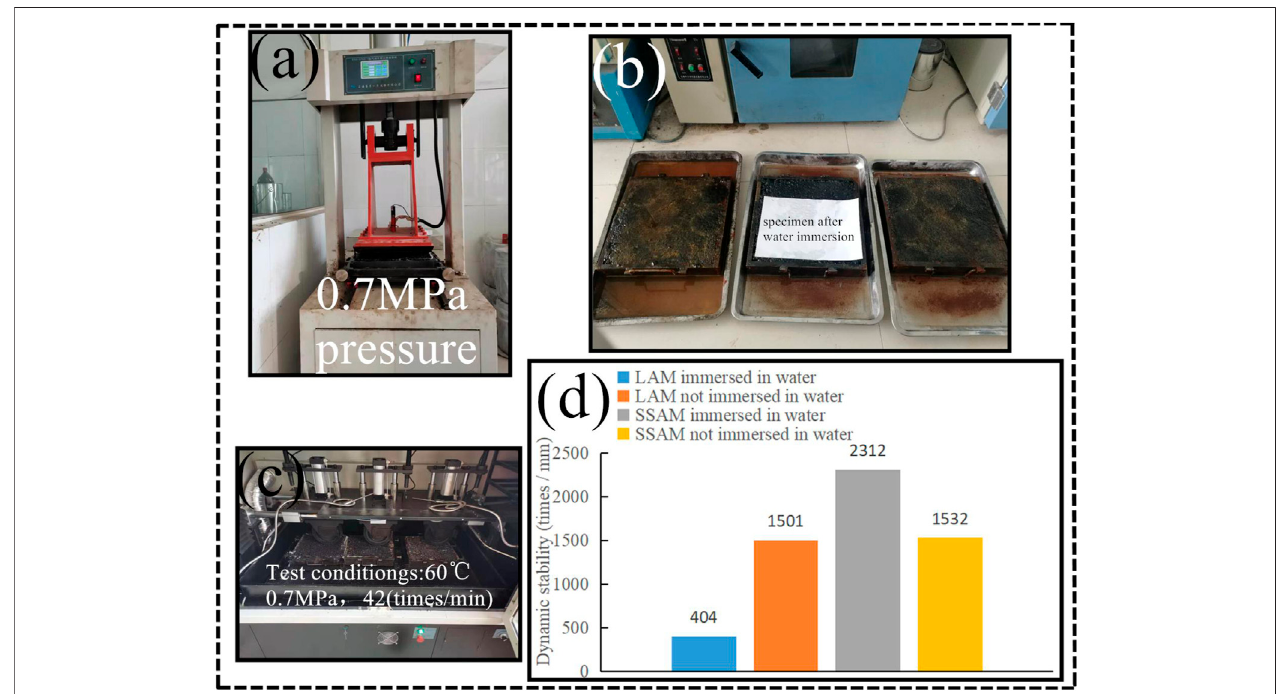
FIGURE 1 | Rutting performance of asphalt mixtures: (A) test piece formation; (B) test piece soaking; (C) rutting test; and (D)